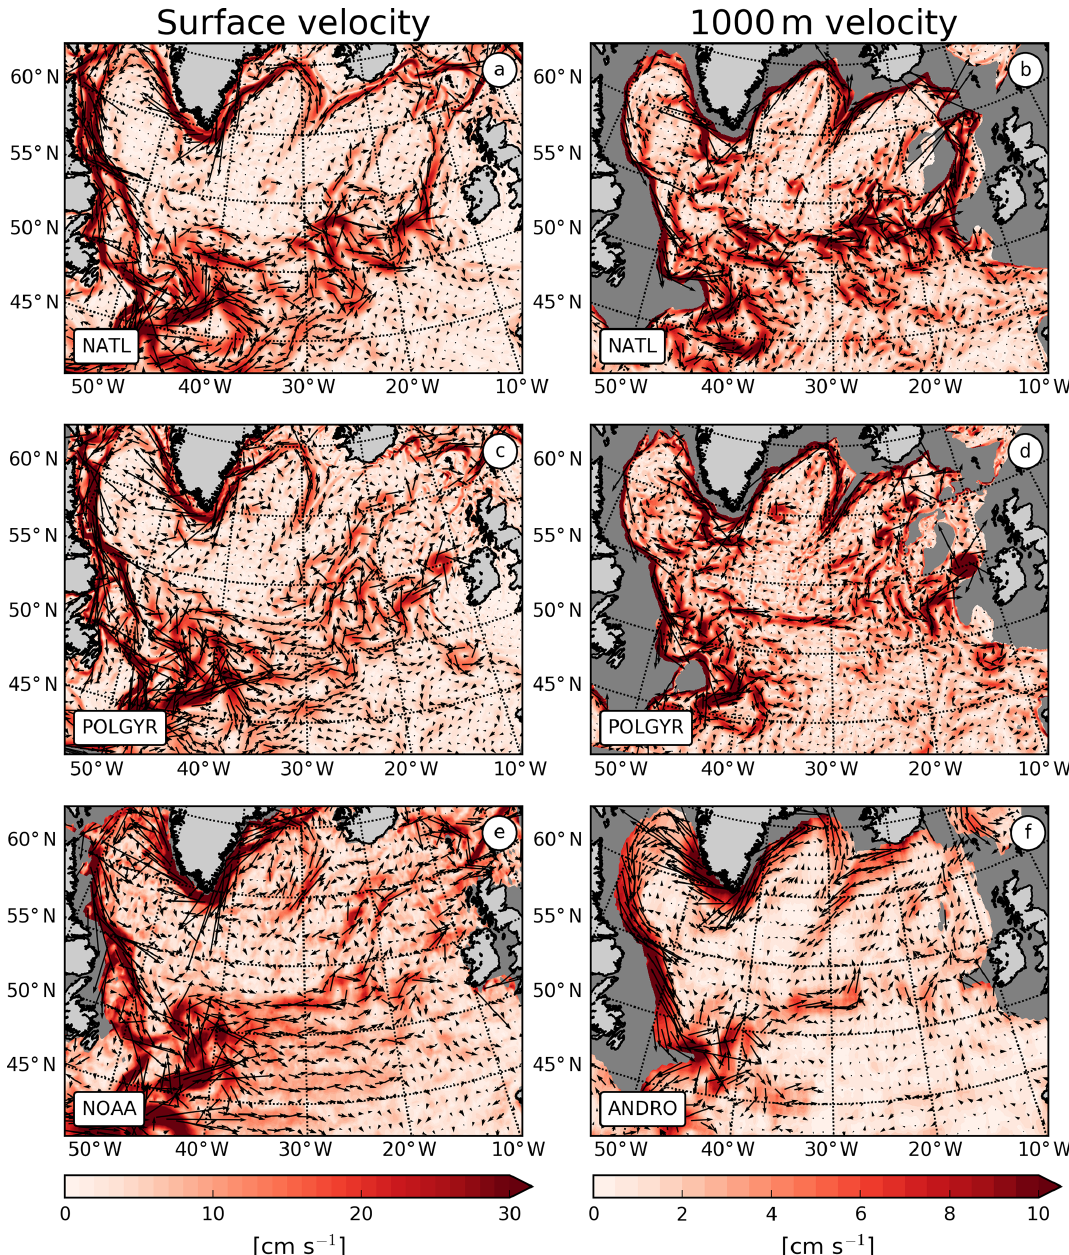
Figure 3. Mean velocity averaged over 2002–2008 at the surface (a, c, e) and 1000m (b, d, f) in NATL (a, b) , POLGYR (c, d) and observations, and NOAA drifters and ANDRO (e, f)